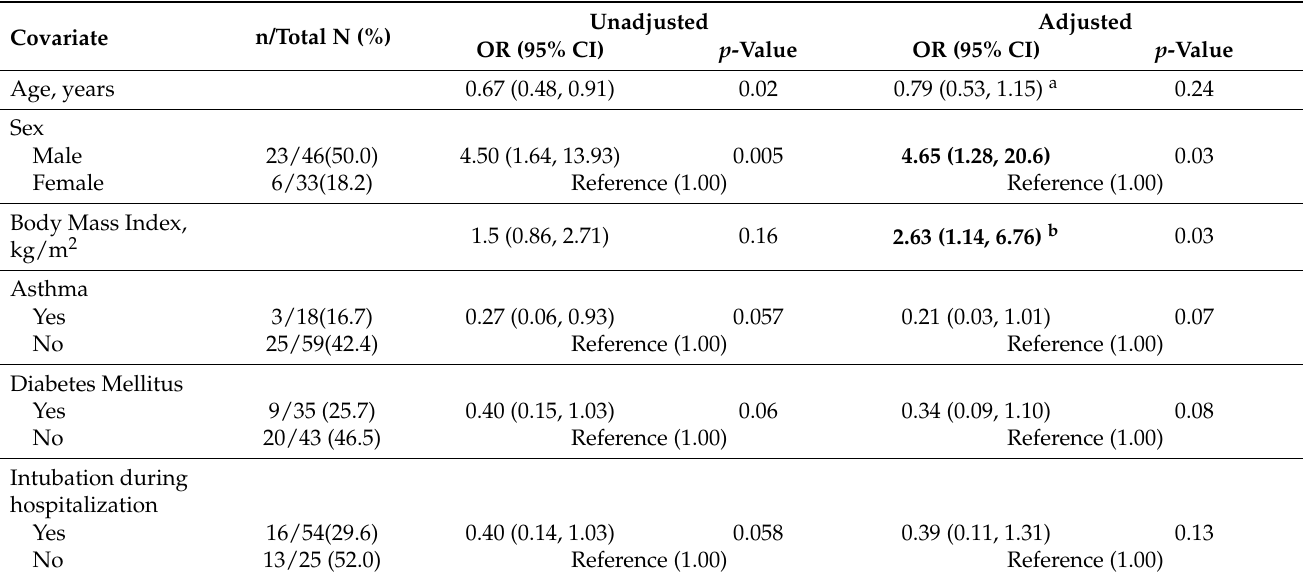
Table 2. Factors associated with functional capacity limitation at 60 days in 79 survivors who received HFNC for COVID-19 pneumonia.